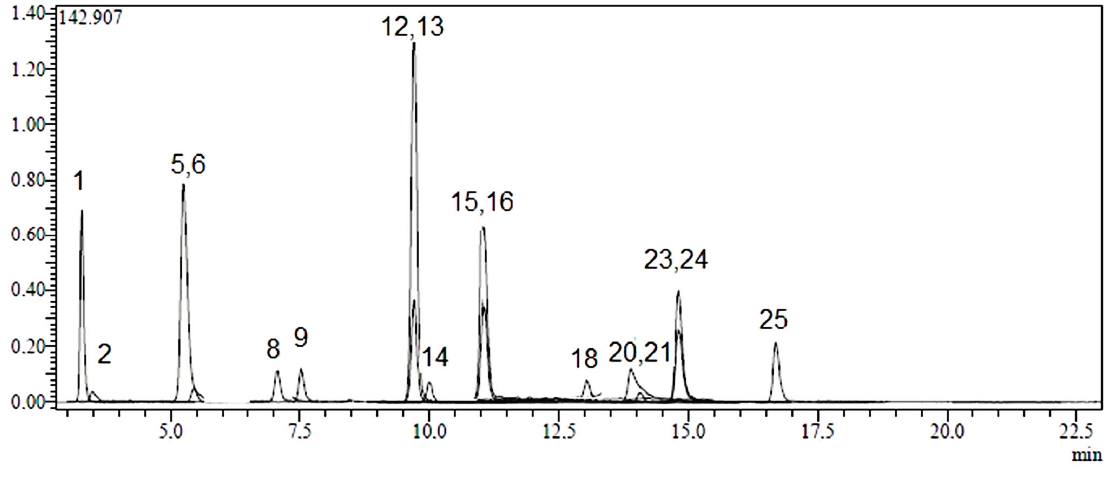
Figure 4. LC-MS/MS chromatograms of AL. Notes: Chromatographic conditions were given in the Experimental